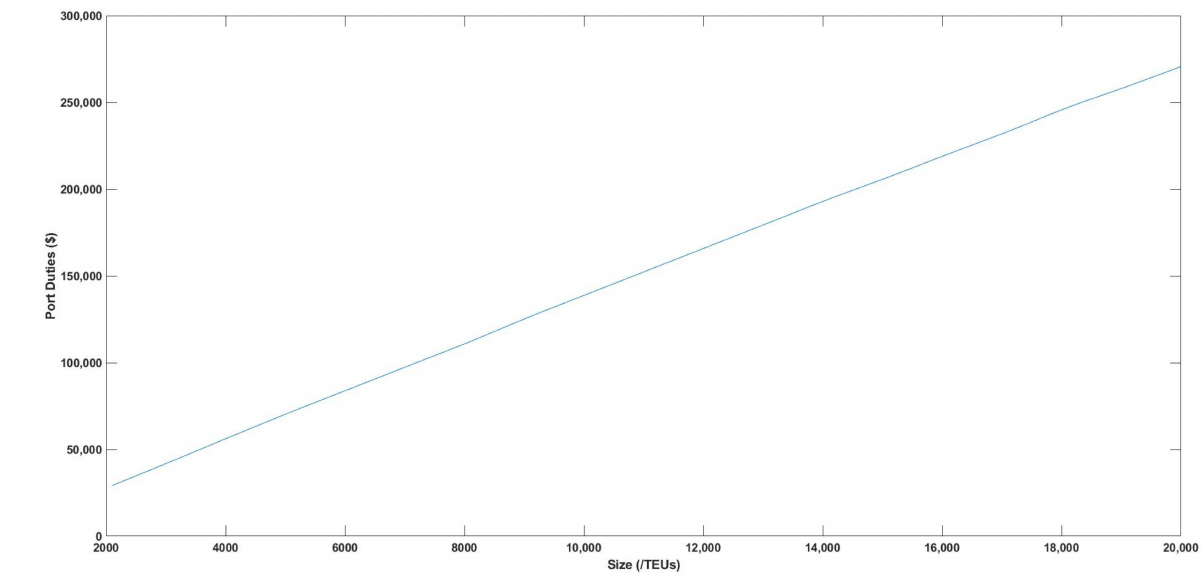
Figure 8. Port duties FP(SS) as function of size in TEUs.